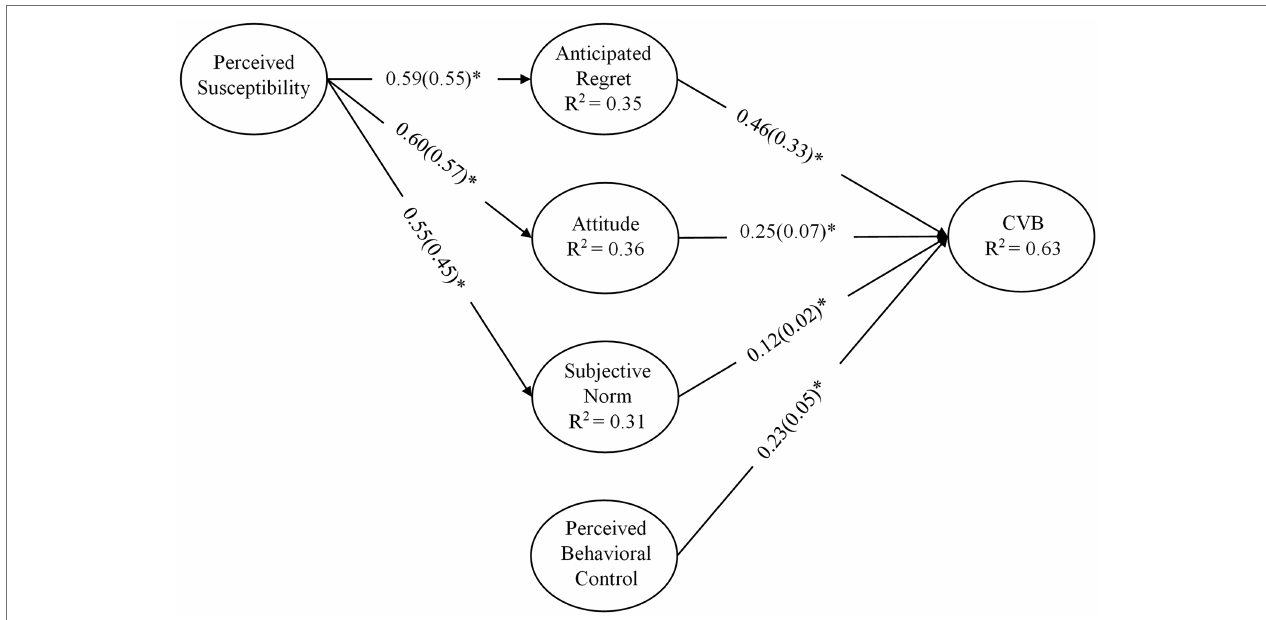
FIGURE 2 | Structural equation modeling (SEM) results of complete data ( n = 680), CVB: COVID-19 vaccination behavior. The * indicates p -values less than 0.01. The figure presents the effect sizes (ƒ 2 ) in the parentheses next to each path coefficient ( β